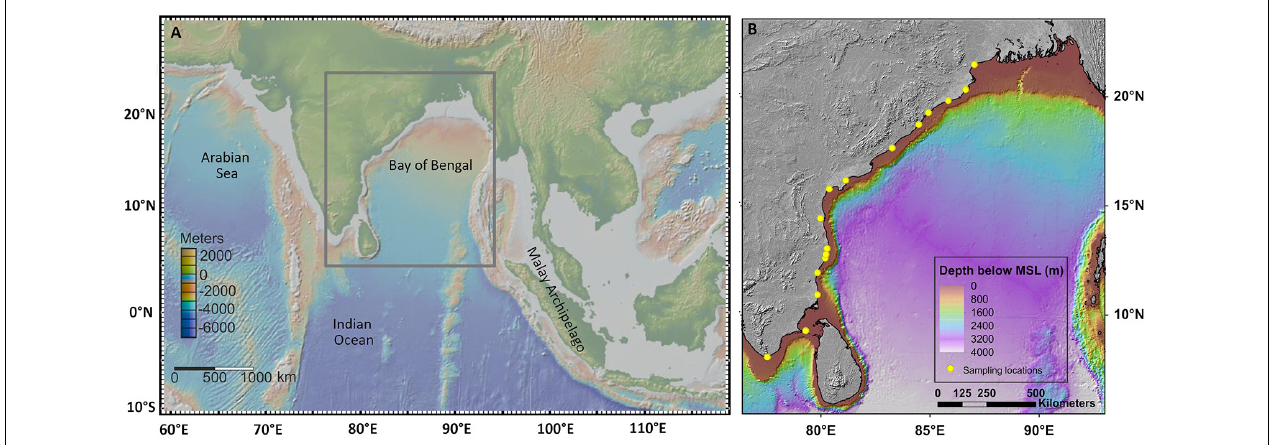
FIGURE 1 | Map of India (A) showing the sampling locations (B) . The map is based on Survey of India Outline map (1996).